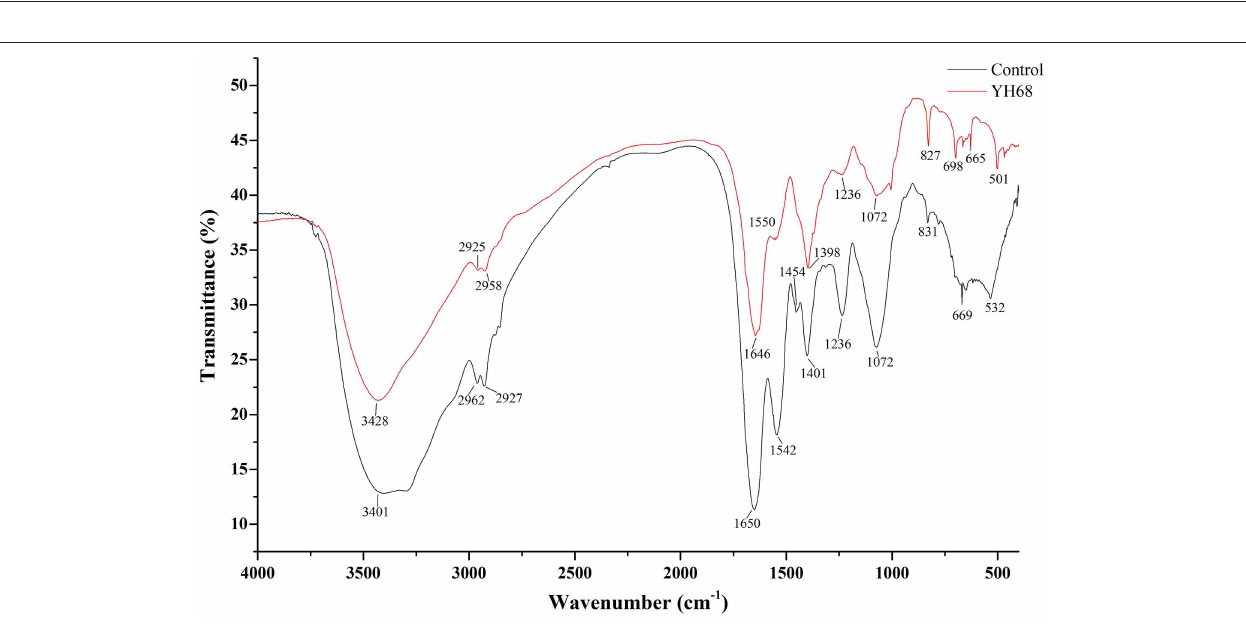
FIGURE 3 | FT-IR spectra of C. difficile ATCC